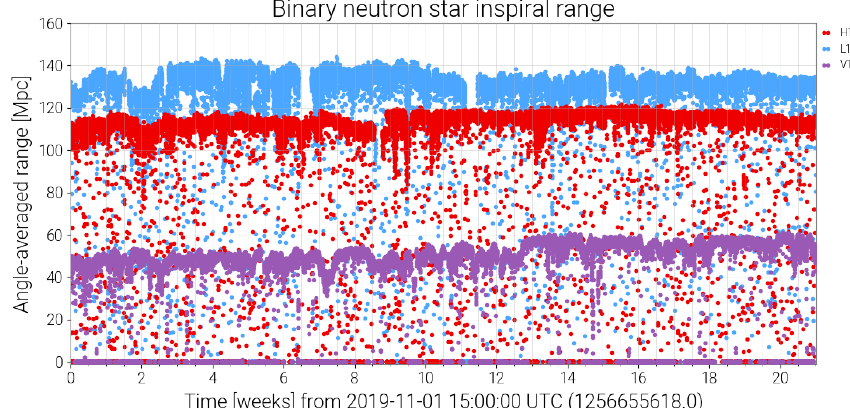
Figure 9. NS-NS Ranges of the HLV Network (LIGO Hanford—LIGO Livingston—Virgo) during the O3b Run. Image from